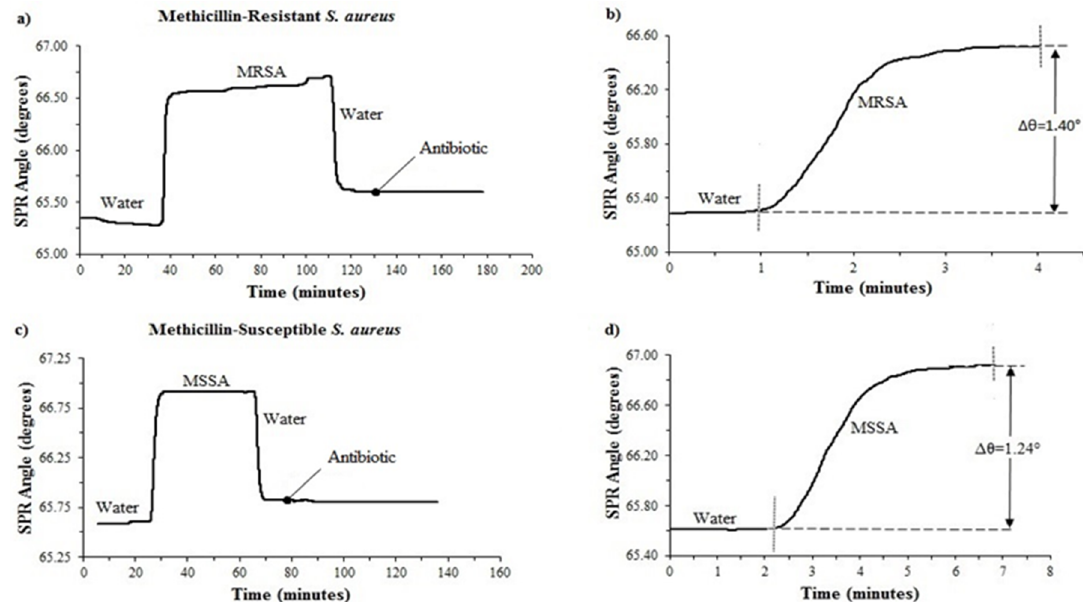
Figure 3. SPR angle shift of methicillin-resistant (the strain of MRSA 2) and susceptible S. aureus (the strain of MSSA 7): ( a ) Kinetic plot of SPR angle shift of methicillin-resistant S. aureus to cefoxitin antibiotic for 60 min; ( b ) SPR response of resistant bacterial insertion; ( c ) kinetic plot of SPR angle shift of methicillin-susceptible S. aureus to cefoxitin antibiotic for 60 min; ( d ) SPR response of susceptible bacterial insertion.